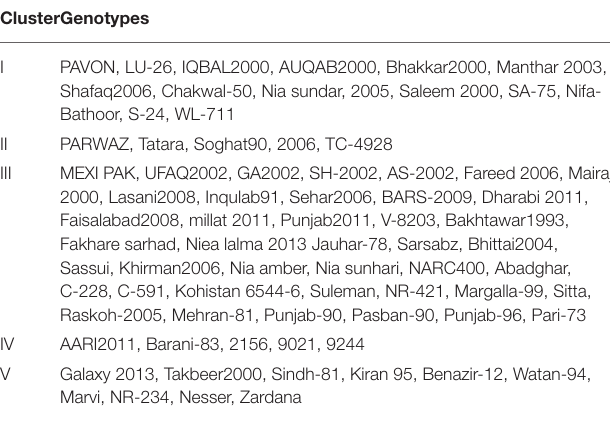
TABLE 6 | Distribution of wheat genotypes regarding grain nutritional profile in different clusters. ClusterGenotypes